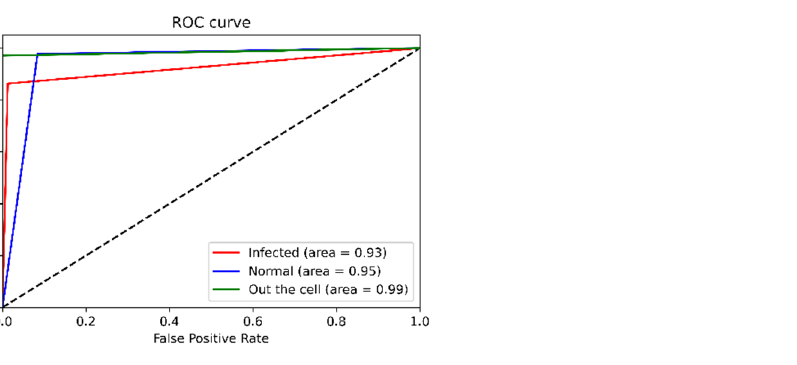
Figure 8. ROC curve presenting the efficiency of the model evaluated by 20% split data from training data set .